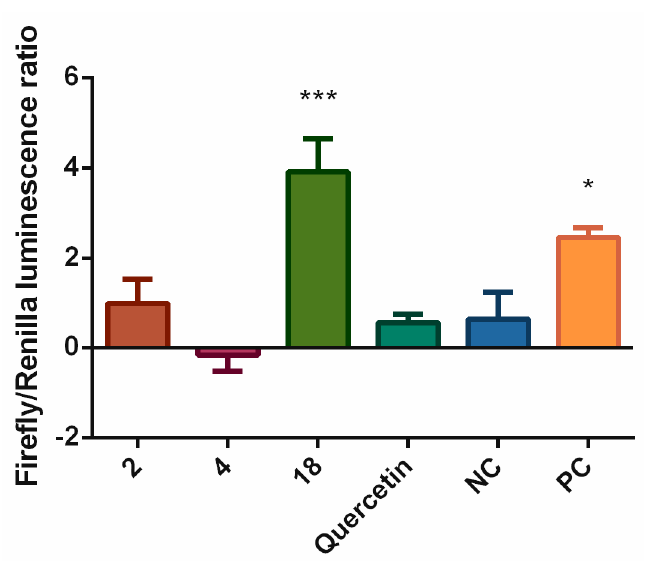
Figure 7. The e ff ects of selected stilbenoids 2 , 4 , and 18 (at a concentration of 2 µ M) on the activation of Nrf2-ARE system. The HepG2 cell model was transiently transfected with the ARE luciferase reporter vector firefly luminescence and a constitutively expressing Renilla vector. The results are expressed as the ratio of firefly to Renilla luminescence. Quercetin was used as the standard (2 µ M), DL-sulforaphane was used as a positive control at a concentration of 10 µ M (PC), and the vehicle alone served as the negative control (NC). * = p < 0.05; *** = p < 0.001.